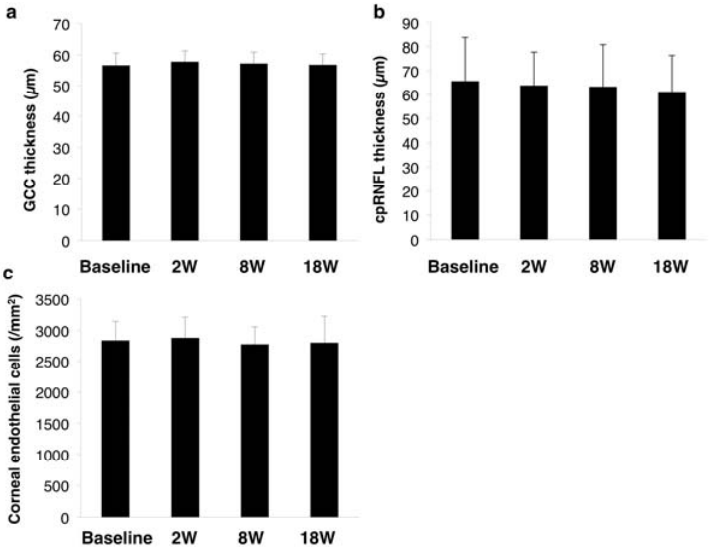
Figure 7. Changes in safety parameters before and after SES: ( a ) the GCC thickness; ( b ) the cpRNFL thickness measured by 3D-OCT; and ( c ) corneal endothelial density measured by specular microscopy. cpRNFL, circumpapillary retinal nerve fiber layer; GCC, ganglion cell complex; OCT, optical coherence tomography; SES, skin electrical stimulation.